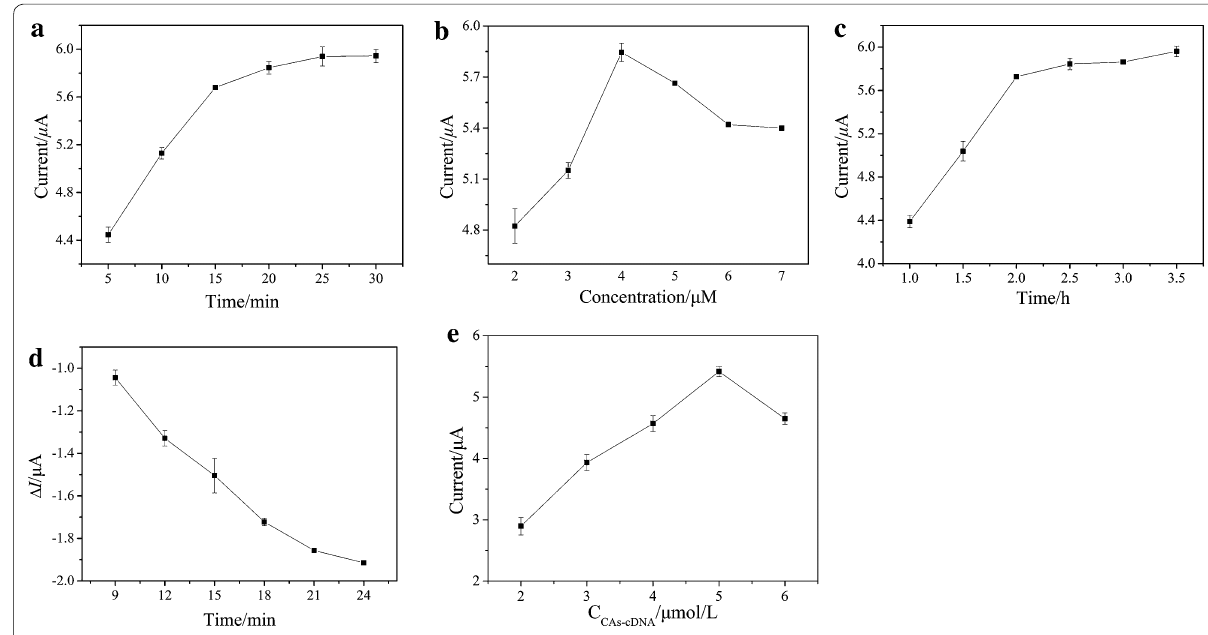
Fig. 5 The effect of a the incubation time of MB, b the aptamer concentration, c the hybridization time between cDNA and aptamer, d the incuba- tion time of OTA, and e the concentration of CAs-cDNA on the CAs-cDNA/apt/AuE